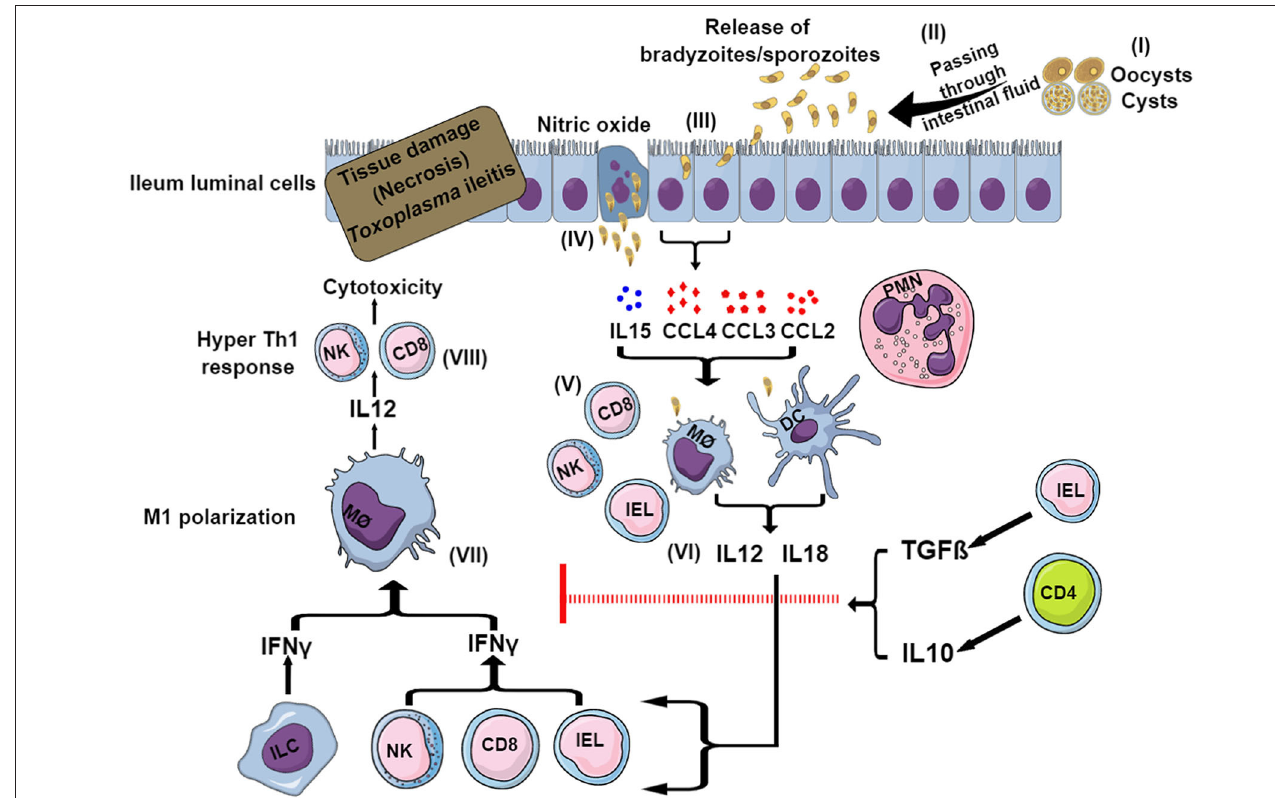
FIGURE 2 | Model for sequential events during Toxoplasma- induced ileitis. Following ingestion of oocysts or tissue cysts, digestive enzymes break their wall and sporozoites or bradyzoites, respectively, are released (I). After invading intestinal epithelial cells, bradyzoites and sporozoites convert to tachyzoites (II) (III).